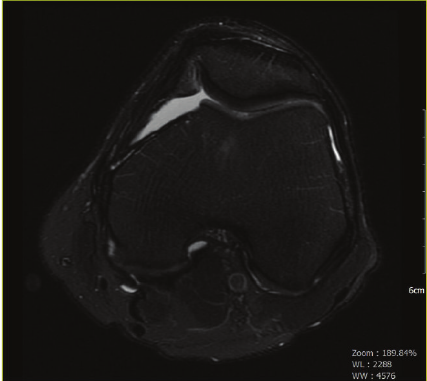
Figure 3: Nine-month postoperative radiograph. Unenhanced MRI of the left knee performed on a 1.5 Tesla magnet. Examination of the area of the femoral patellar joint where the patient is status- post a chondroplasty of the trochlear groove shows low T1 and high T2 signals in the subchondral bone. The articular surface of the chondroplasty defect shows a signal, which is isointense with articular cartilage. The thickness of the signal is less than that of the adjacent cartilage.